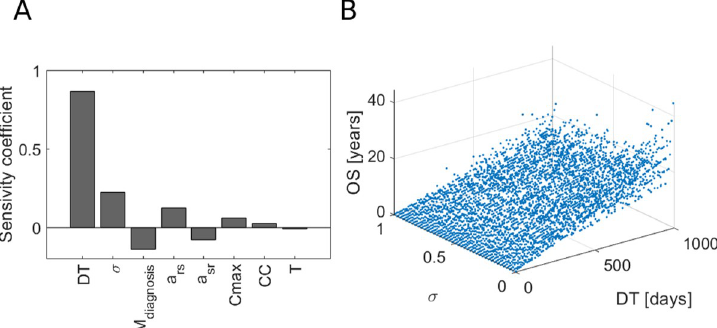
Fig 2. Selection of key model parameters affecting overall survival. A) Global sensitivity analysis (GSA) for eight model parameters with the overall survival as an output. B) Overall survival as a function of the two most sensitive parameters DT and σ